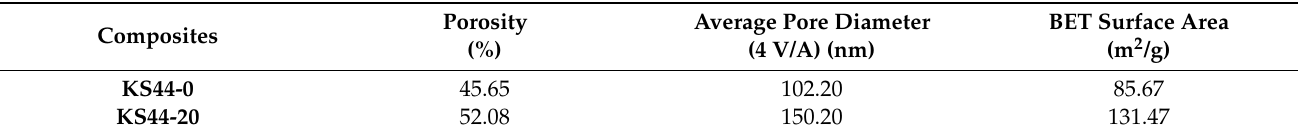
Figure 2. SEM micrographs at different scales of the material: ( a , b ) carbon graphite (KS44 ‐ 0) and ( c , d ) carbon graphite/CNT composite (KS44 ‐ 20). Table 1. Textural parameters of KS44-0 and KS44-20 detected with BET method and mercury intrusion porosimetry technique [12].